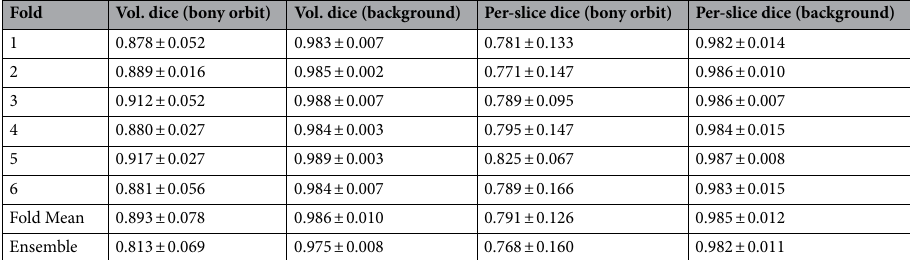
Table 2. Results summary with the mean ± standard deviation for volumetric and per-slice Dice for the MRI dataset. The values for the individual folds are presented along with their mean and the ensemble (based on majority voting).